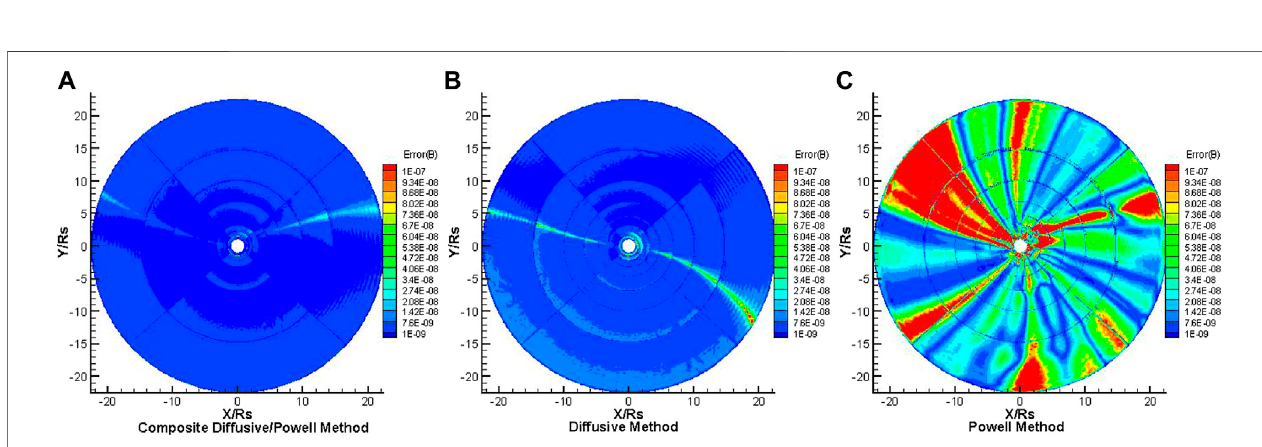
FIGURE 7 | The distribution of Error ( B ) on the meridional plane of Φ (cid:2) 270 ° – 90 ° from 1 to 22.5R S , the results from composite diffusive/Powell method (A) , diffusive method (B) and Powell method (C) , respectively.